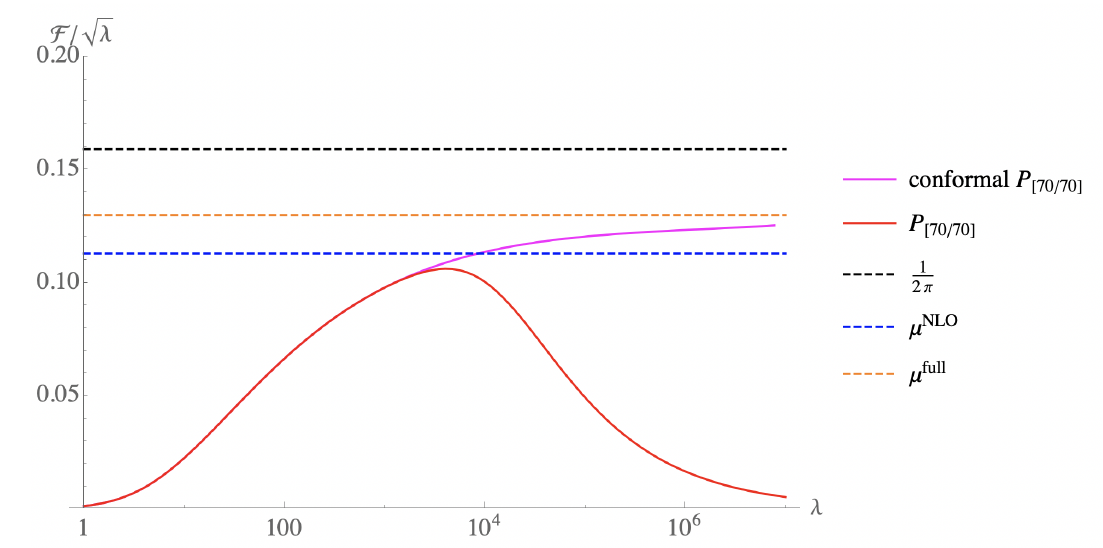
√ Figure 6 . Comparison between various estimations of F / λ . The highest horizontal line is the expected asymptotic constant using the LO analytical prediction. The other horizontal lines are the prediction from the truncated matrix analysis using the NLO expansion of the M matrix elements or their “full” integral representation. Also shown are the simple and conformally improved Padé resummations taken from [8]. Notice that a residual steady increase of the purple curve at quite large values of λ is clearly visible in the adopted logarithmic